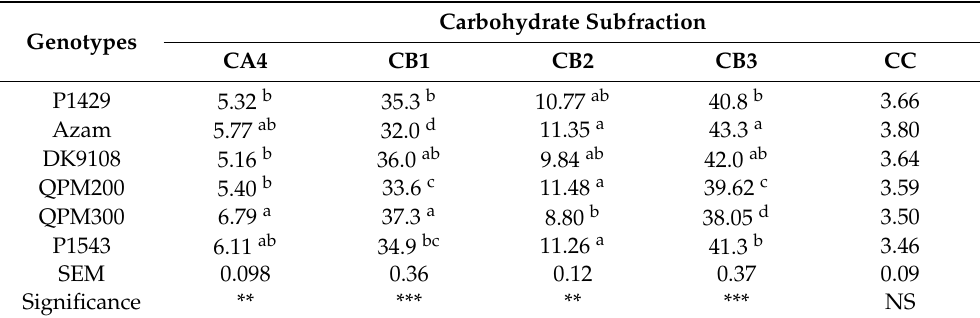
Table 6. The effect of spring genotypes on Cornel Net Carbohydrate and Protein System (CNCPS) carbohydrate subfractions of maize silages.